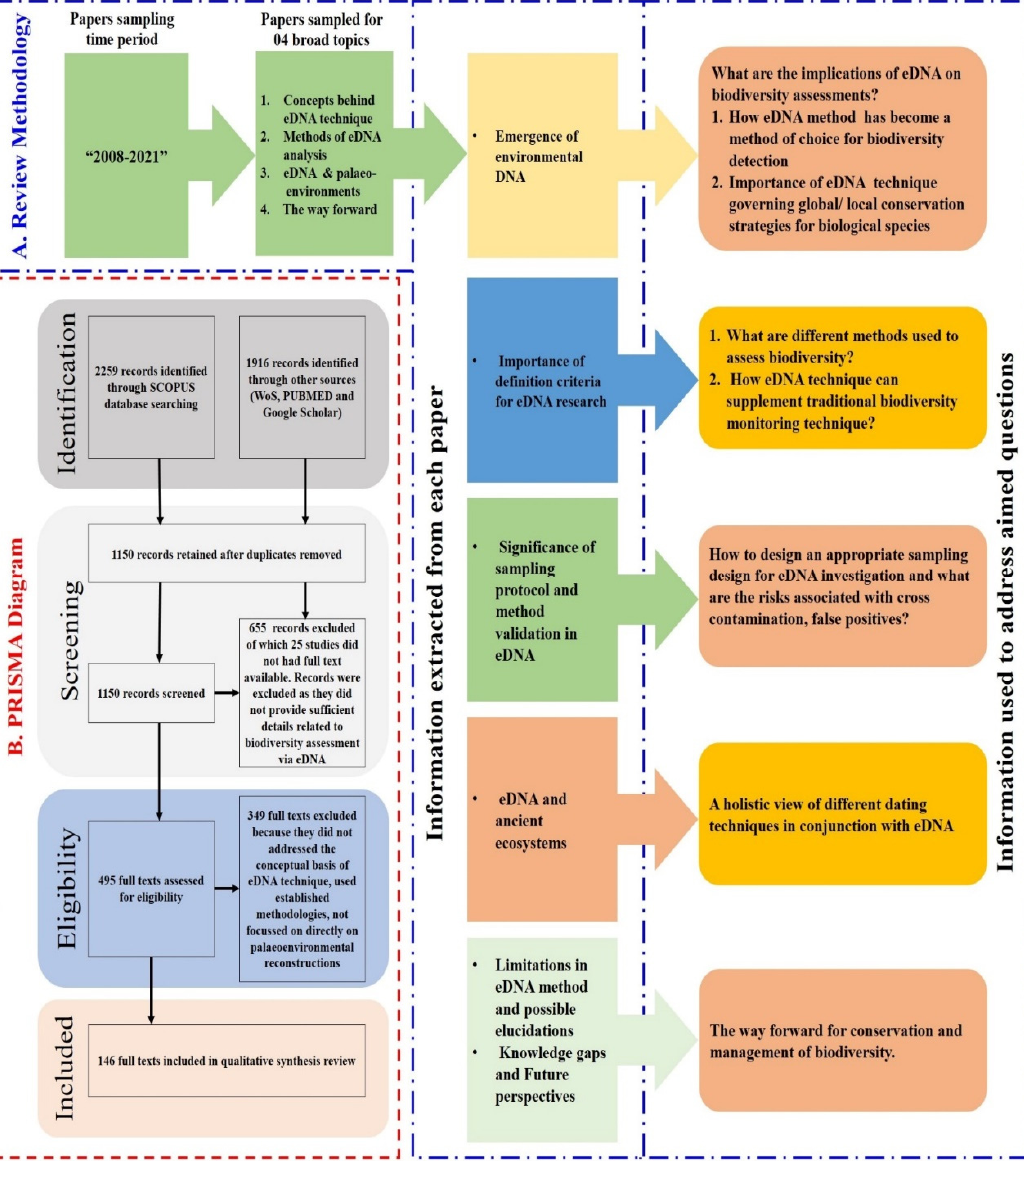
Figure 1. Overview of the review methodology. ( A ) Literature review design, information collected, and research questions. ( B ) PRISMA methodology flow chart showing the selection and rejection of papers. Of the original 4175 articles, 495 were evaluated for eligibility based on the relevant questions, aims, and objectives.